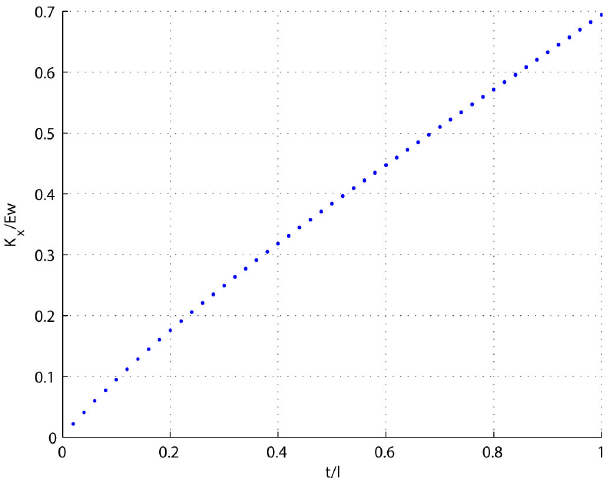
Figure 9. Sti ff ness in y direction dimensionless design parameter.